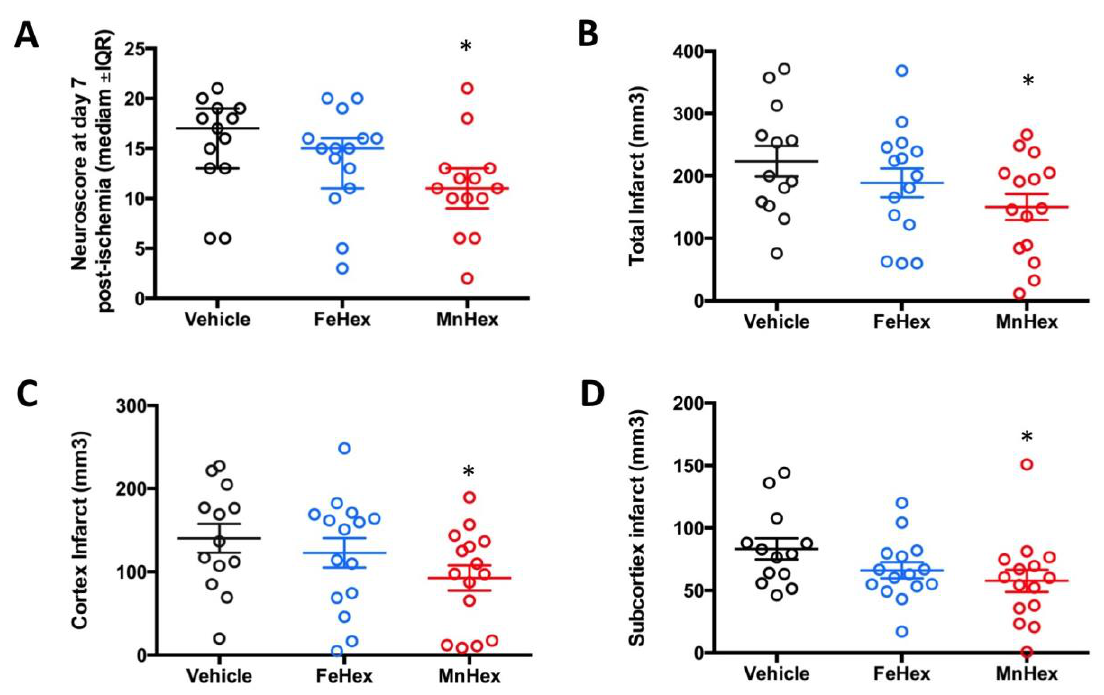
Figure 9. Evaluation of the neurologic outcome in terms of neuroscore and infarct volumes in a 7-day rat MCAO stroke study. Rats were either non treated (vehicle) or treated with FeHex and MnHex at 0.225 mg / kg twice per day for 7 days ( n = 15–16). The first dose was given slowly IV via the tail artery at 5 min after reperfusion and the subsequent doses were given SC. At day 7 post-injury, a person blind to the treatment groups assessed the neurological deficit, at which point brains were harvested for infarct volume measurement. Neuroscore ( A ): p = 0.016 MnHex vs. Vehicle; p = 0.28 FeHex vs. Vehicle. Total infarct volume ( B ): p = 0.029 MnHex vs. Vehicle; p = 0.31 FeHex vs. Vehicle. Cortex infarct volume ( C ): p = 0.046 MnHex vs. Vehicle; p = 0.48 FeHex vs. Vehicle. Subcortex infarct volume ( D ): p = 0.049 MnHex vs. Vehicle; p = 0.11 FeHex vs. Vehicle. The “star” (*) symbol denotes